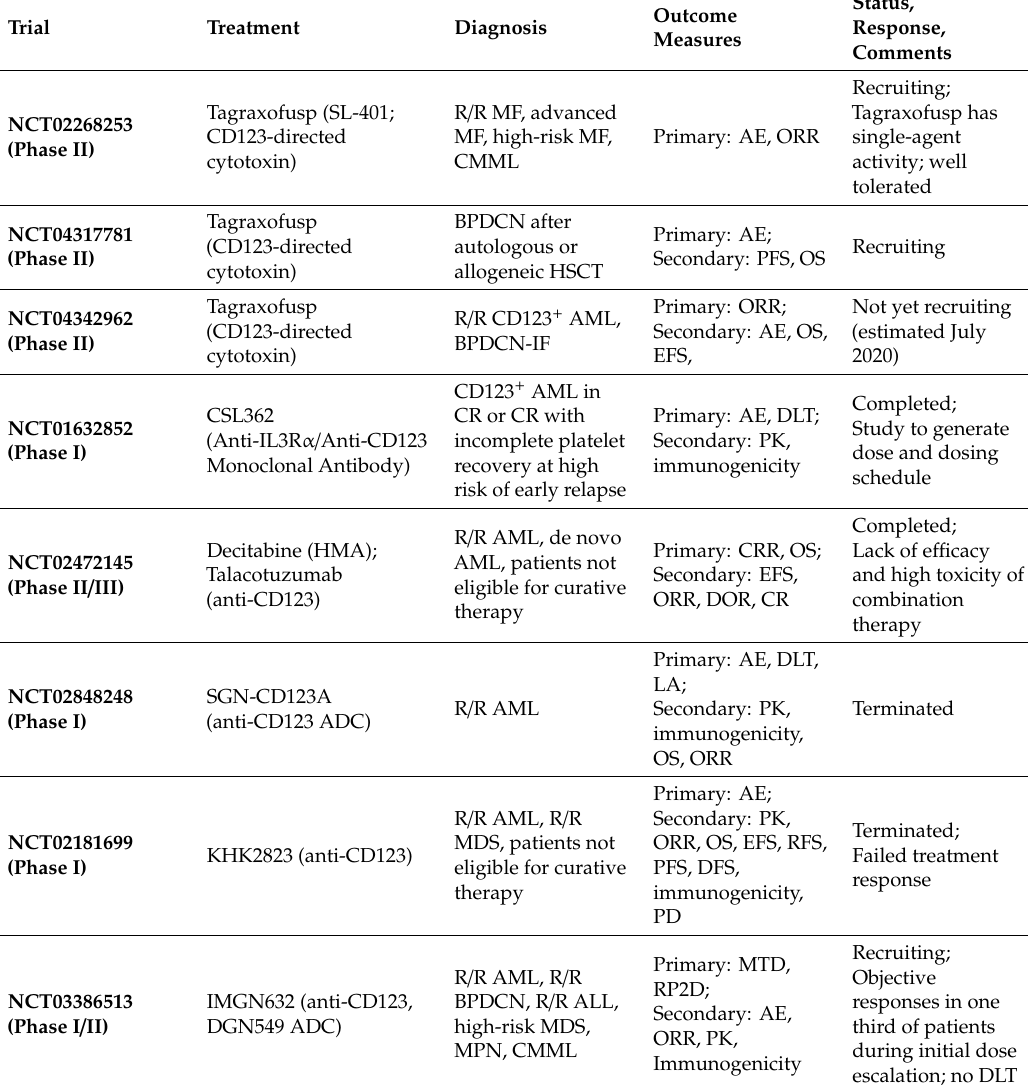
Table 2. Selected Clinical Trials of CD123-directed therapy in myeloid malignancies. Trial